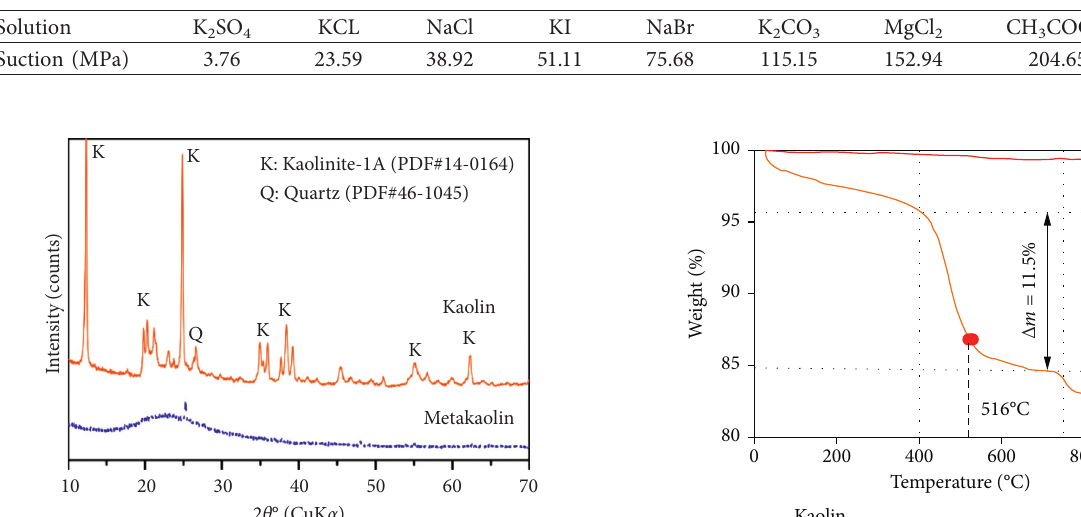
Table 4: Saturated salt solution and corresponding suction values ( T � 25 ° C).